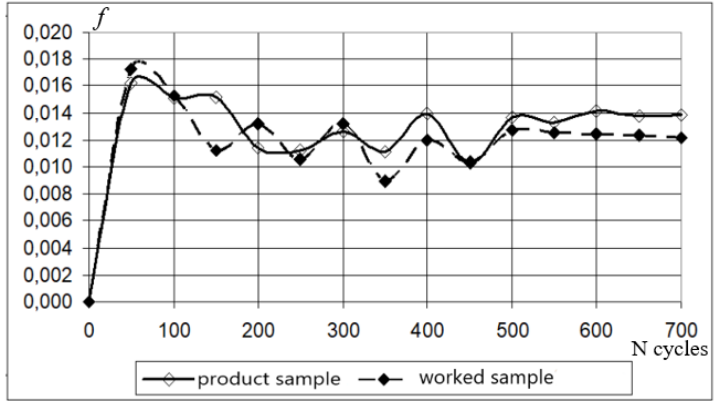
Fig. 2. Kinetics of friction coefficient change at operating time for commercial and used Mobil-1 0w-40 oil at 120 0 C lubricant volumetric temperature